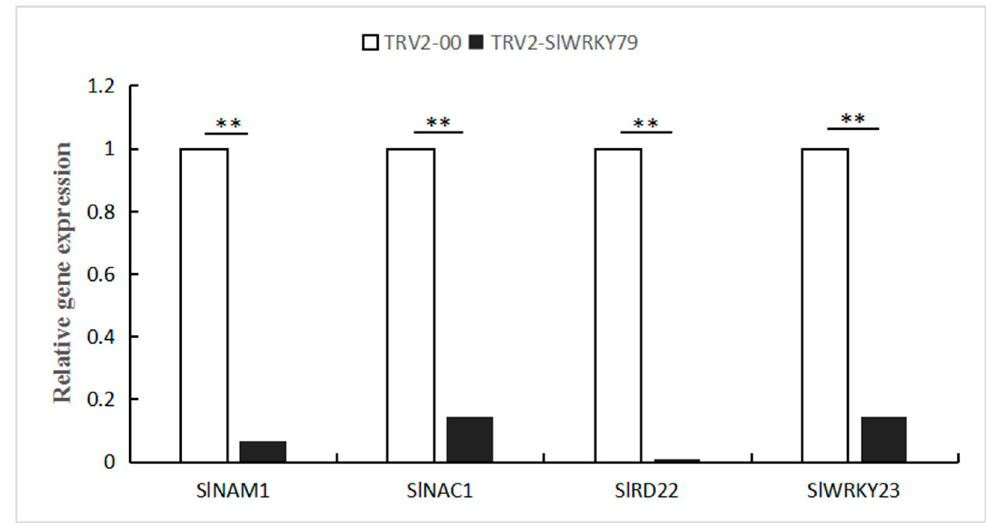
Figure 7. Comparison of SlNAM1 , SlNAC1 , SlWRKY23, and SlRD22 expression in TRV2-00 and TRV2- SlWRKY79 cells. The data presented are the means ± SDs of three independent experiments, and the different symbos above the columns indicate significant differences at the p < 0.05 level. **: p < 0.01.